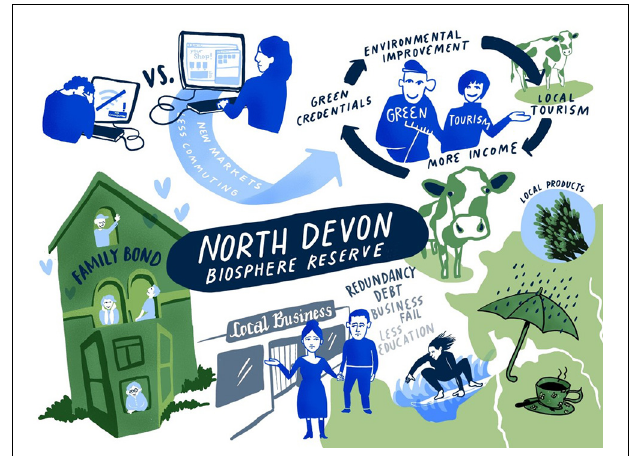
FIGURE 5 | COVID-19 scenario for North Devon Biosphere Reserve. Illustration by Lina Ernst Illustrations.